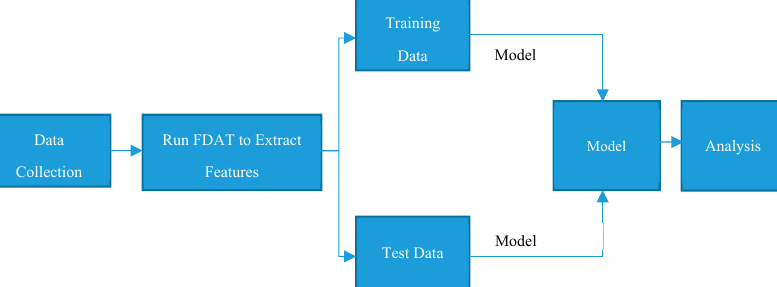
Figure 2. Work flow summarising the analytical steps followed. “Data” includes both data collation and extraction.